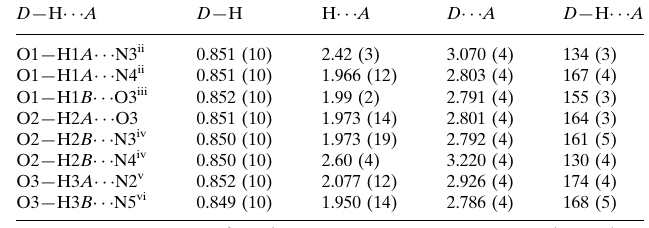
Hydrogen-bond geometry (A˚ , (cid:2)